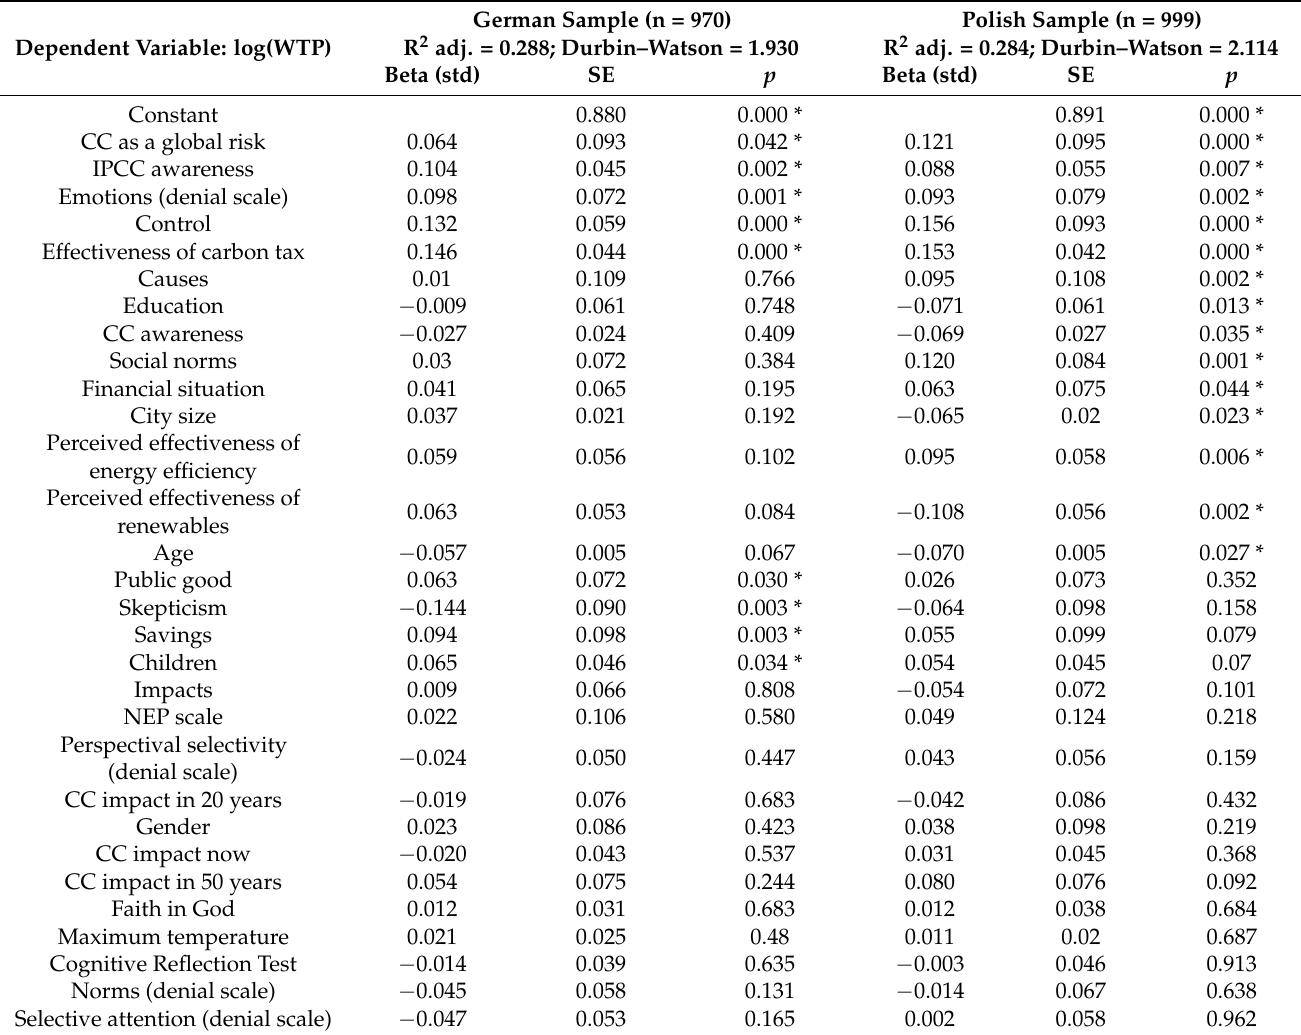
Table 3. Results of linear regression conducted separately on samples from Germany and Poland. Statistically significant variables, at p < 0.05, are marked with